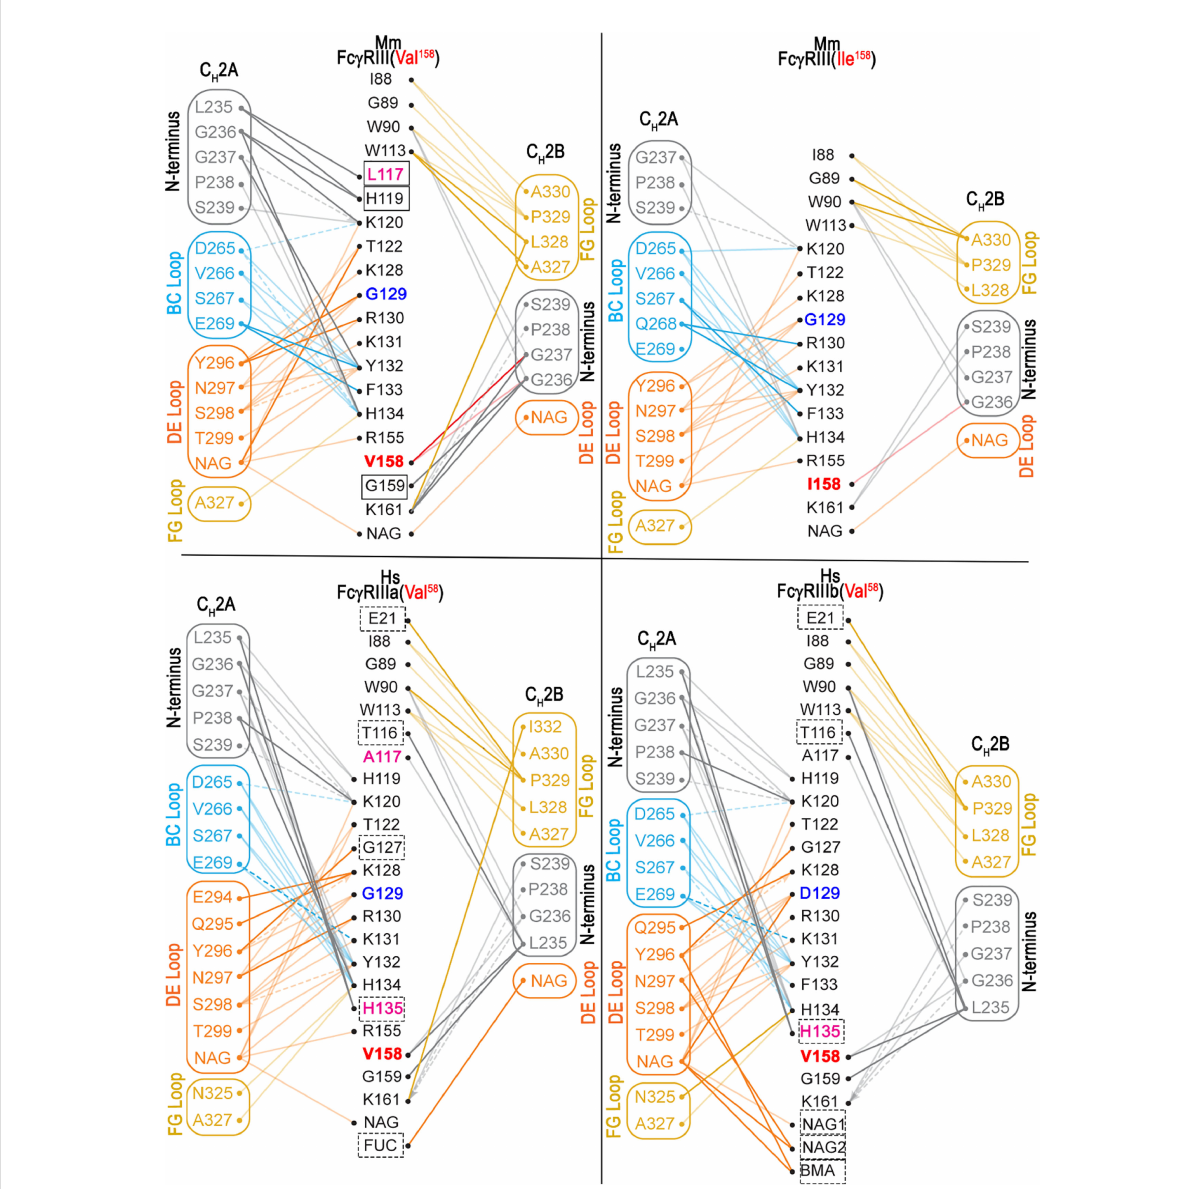
FIGURE 4 Networks of interactions formed between Fc g RIII receptors and the two Fc monomers (C H 2-C H 3 domains). The two Fc monomers are labeled as A and B chains. The residues in the N-terminus and the BC, DE, FG loops are colored in gray, cyan, orange and yellow, respectively. The top two panels show the networks of interactions between the two Mm Fc g RIII-Fc(IgG1) complexes and the bottom two panels show the networks of interactions between the two Hs Fc g RIIIa/b-Fc(IgG1) complexes (PDB: 5XJE and 6EAQ). Networks of interactions de fi ned by a 5-Å distance criterion cutoff are shown as dotted lines for main chain-main chain interactions and dashed lines for main chain to side chain interactions with the arrows indicating the residues that contribute to the side chain interactions. Darker versus lighter color lines for the Hs Fc g RIIIa/b-Fc(IgG1) complexes and the Mm Fc g RIII(Ile 158 )-Fc(IgG1) complex represent those contacts that are unique as compared to the Mm Fc g RIII(Val 158 )-Fc (IgG1) complex. Darker versus lighter color lines for the Fc g RIII(Val 158 )-Fc(IgG1) complex are those that are unique relative to the Mm Fc g RIII (Ile 158 )-Fc(IgG1) complex. Lighter color lines represent those that are common between the comparisons. Additional residues that contribute to the buried surface area (BSA) of the Mm Fc g RIII(Val 158 )-Fc(IgG1) complex relative to the Mm Fc g RIII(Ile 158 )-Fc(IgG1) are indicated with boxes. Additional residues that contribute to the BSA difference between the two Hs Fc g RIIIa/b-Fc(IgG1) complexes relative to the Mm Fc g RIII(Val 158 )-Fc complex are indicated with dashed boxes. Residues that are different between the Mm Fc g RIII-Fc(IgG1) complexes and the Hs Fc g RIIIa/b-Fc (IgG1) complexes are colored in magenta. Residues that are unique to Fc g RIIIb(Val 158 )-Fc(IgG1) complex are colored in